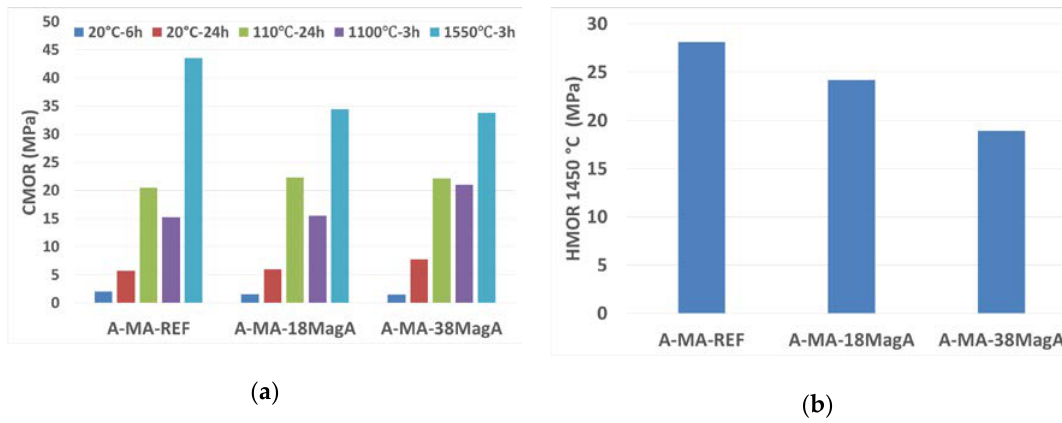
Figure 3. Cold modulus of rupture (CMOR) after curing at 20 °C and after heat treatment ( a ) and hot modulus of rupture (HMOR) at 1450 °C ( b ).